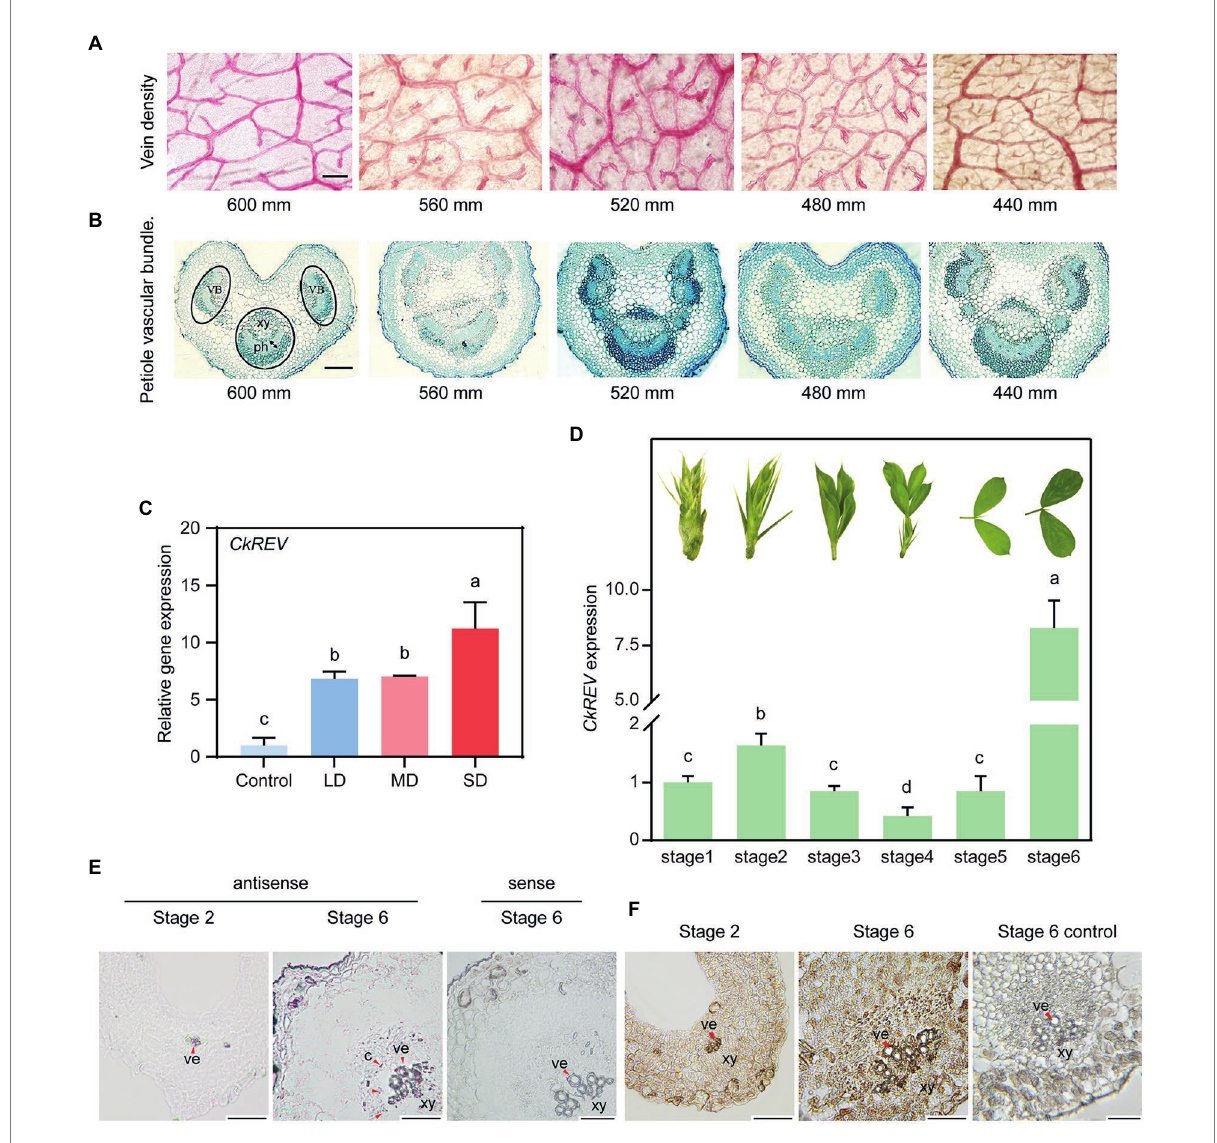
FIGURE 1 Drought induces the secondary development of conducting tissue in Caragana korshinskii leaves and the analysis on CkREV expression pattern. (A) Observation of vein density of C. korshinskii leaves under different rainfall gradients. (B) Observation of vascular bundle morphology in C. korshinskii petiole sections under different rainfall gradients. (C) qRT-PCR analysis on the expression level of CkREV after C. korshinskii was treated with natural drought for different durations. LD, light drought; MD, moderate drought, SD, Severe drought. (D) The development of C. korshinskii is divided into Stage1-Stage6 and qRT-PCR is performed on leaves of different stages to test CkREV level. Pictures above each column indicate leaf shape of that stage. (E) Tissue distribution of CkREV among different developmental stages of vein detected by RNA in situ hybridization. Purple signal signifies positive and red arrows are employed to indicate the position. ve, vessel; c, cambium; xy, xylem. (F) Tissue distribution of CkREV protein among different developmental stages of vein detected by immunohistochemical staining. Brown signal signifies positive and red arrows are employed to indicate the position. ve, vessel; xy, xylem; mm, stands for millimeters; which is the unit of rainfall. Error bars indicate SD ( n = 3). (C , D) One-way ANOVA is performed for the statistical analysis, where different letters represent significant differences ( p < 0.05). Scale bars in (A , B , E , F) = 50 μ